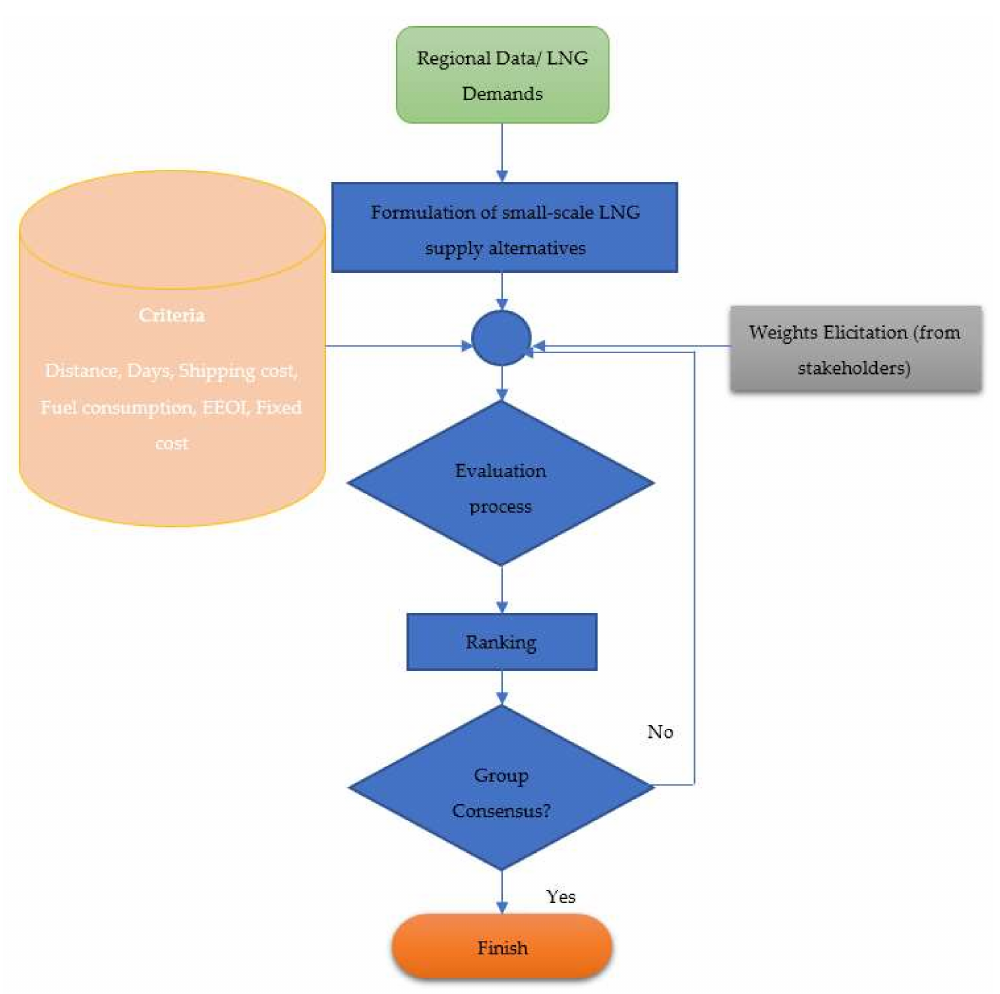
Figure 1. The diagram of the